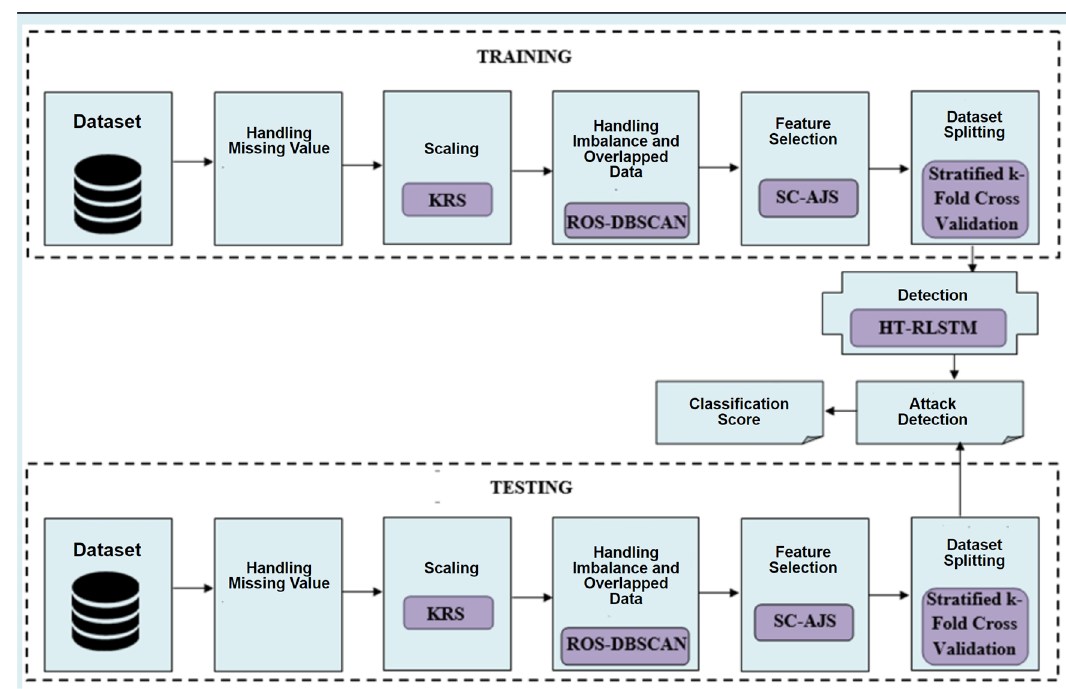
Figure 1. Proposed framework for intelligent cyber security.